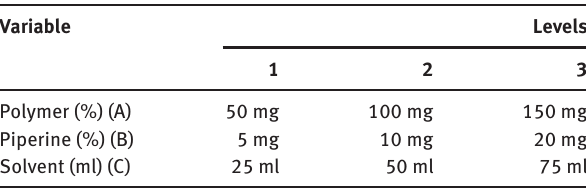
Table 1: Dependent variables and their respective levels used in the experiments.